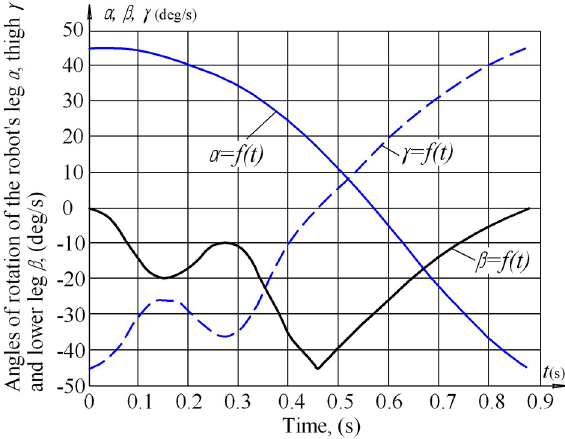
Figure 6. Change in time of the angles of rotation of the supporting leg α = f ( t ) , thigh γ = f ( t ) , and lower leg β = f ( t )